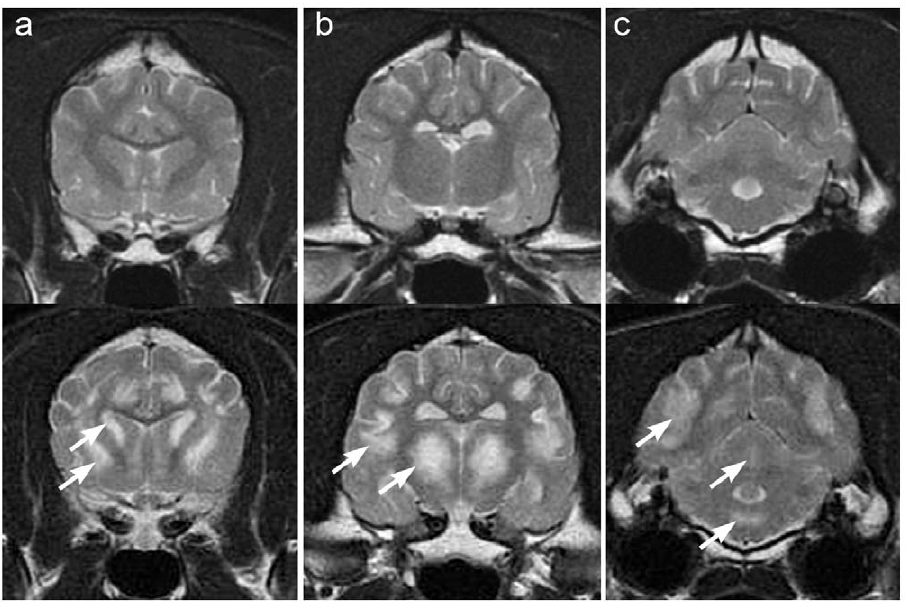
Figure 1. (upper panel). MRI images (T2-weighted, transverse) of a normal brain from a clinically normal 1 year old male Alaskan Husky (C # 1). Figure 1 and 2 a are at the level of the head of the caudal nucleus, Figure 1 and 2 b are at the level of the temporomandibular joint, and Figure 1 and 2 c are at the level of the bulla. Lower panel: MR images (T2 weighted, transverse) from the brain of dog # 3 with neuropathologically confirmed AHE. There are multifocal regions of abnormal hyperintensity in the brain, which are bilateral and symmetrical (arrows). a. Hyperintense lesions are present in the lateral aspect of the caudate nucleus, claustrum and putamen. b. Bilaterally symmetrical lesions in the thalamus and at the base of the sulci, at the junctional grey and white matter in the cerebral hemispheres. c. Hyperintense lesions in the medulla, vermis of the